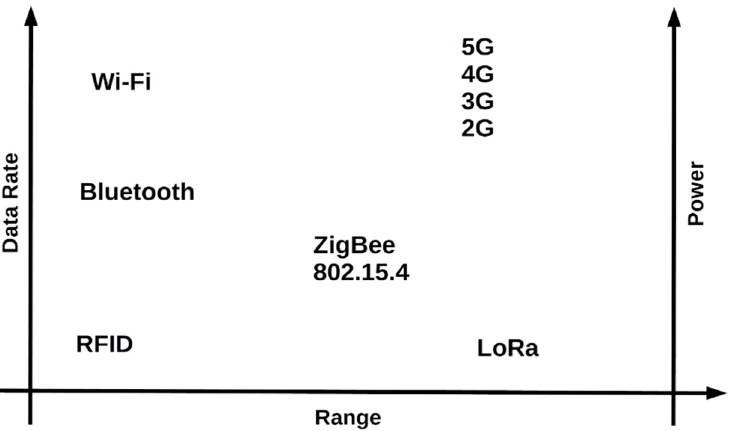
Figure 2. Comparison between commonly used wireless communication technologies regarding data transfer rate, coverage range, and power consumption.